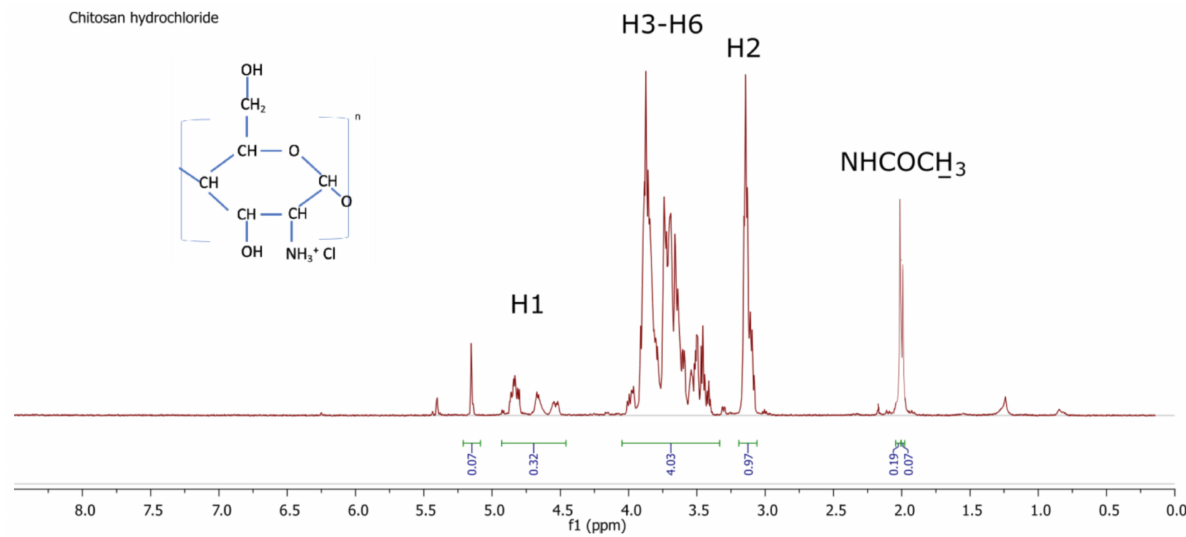
Figure 5. 1 H-NMR spectrum of chitosan hydrochloride.